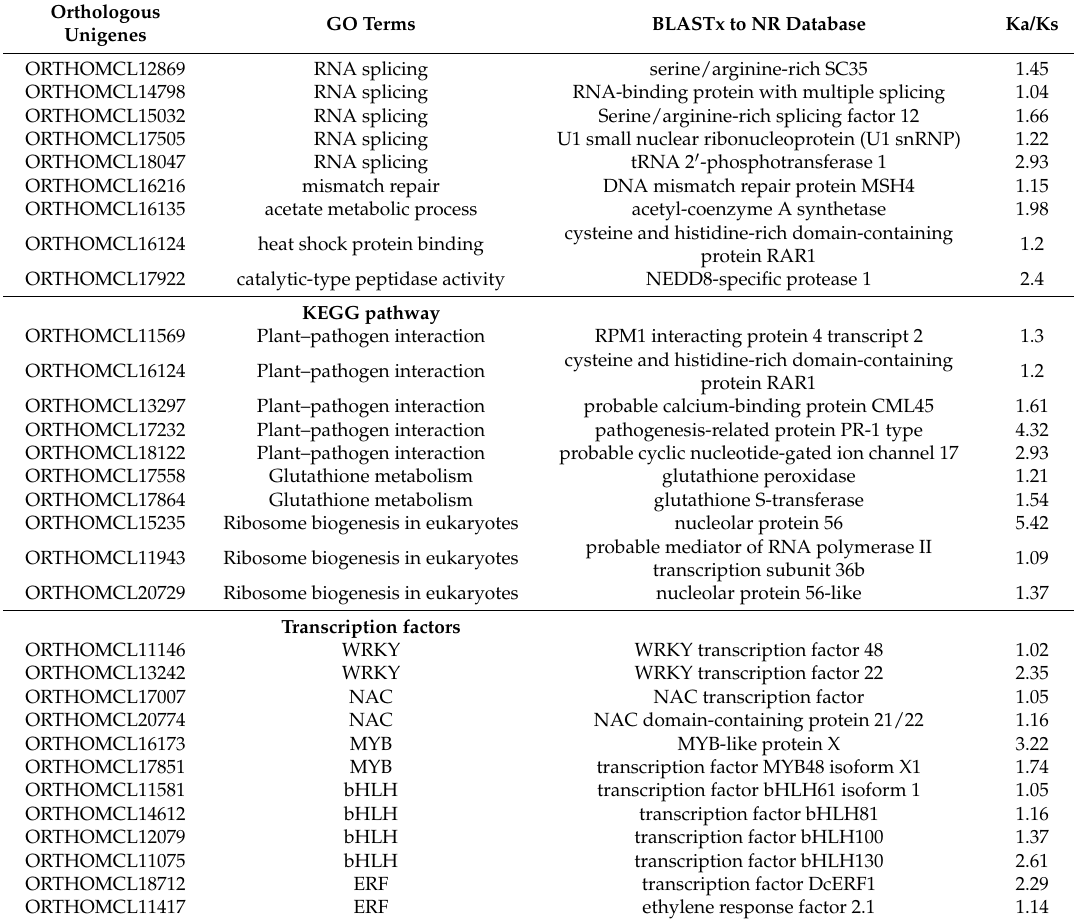
Table 3. Putative genes involved in stress tolerance in orthologous unigenes. Orthologous